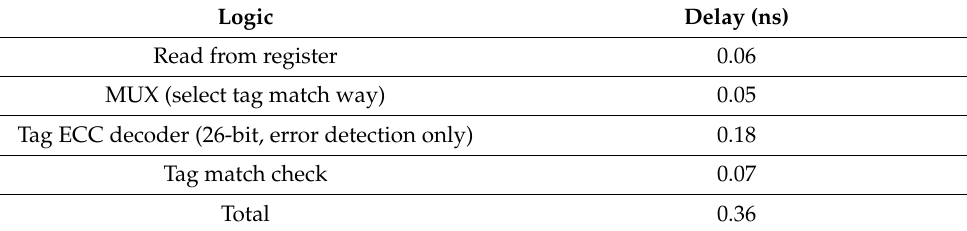
Table 6. Tag read path stage 1 timing of the high-performance path.